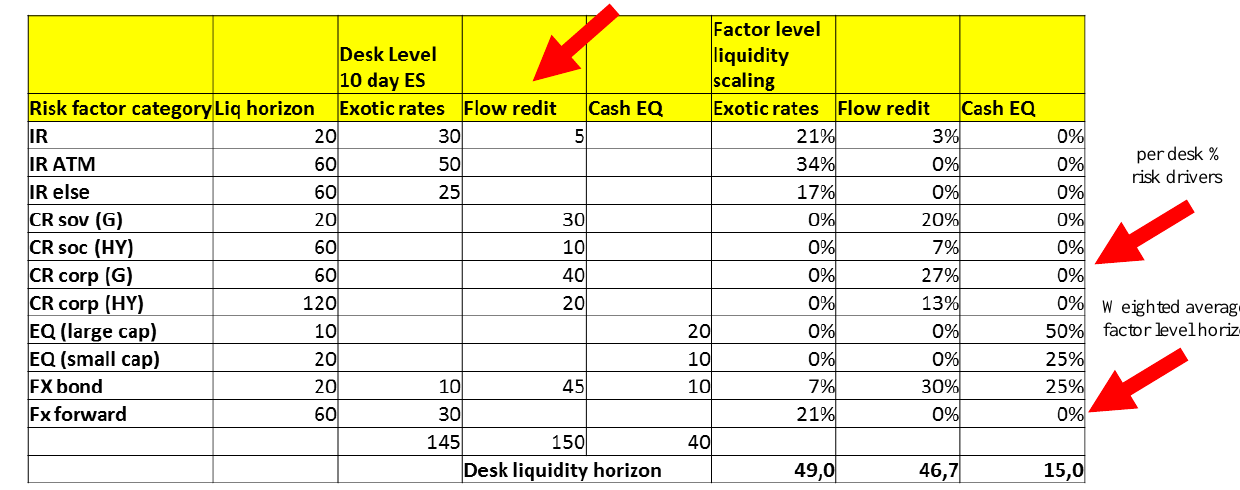
Table 8. Deriving desk level liquidity